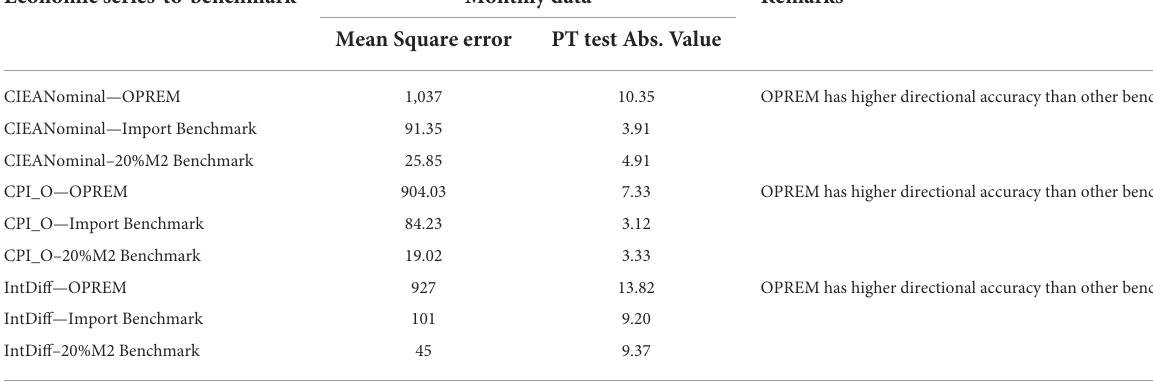
TABLE 7 Pesaran-Timmermann test